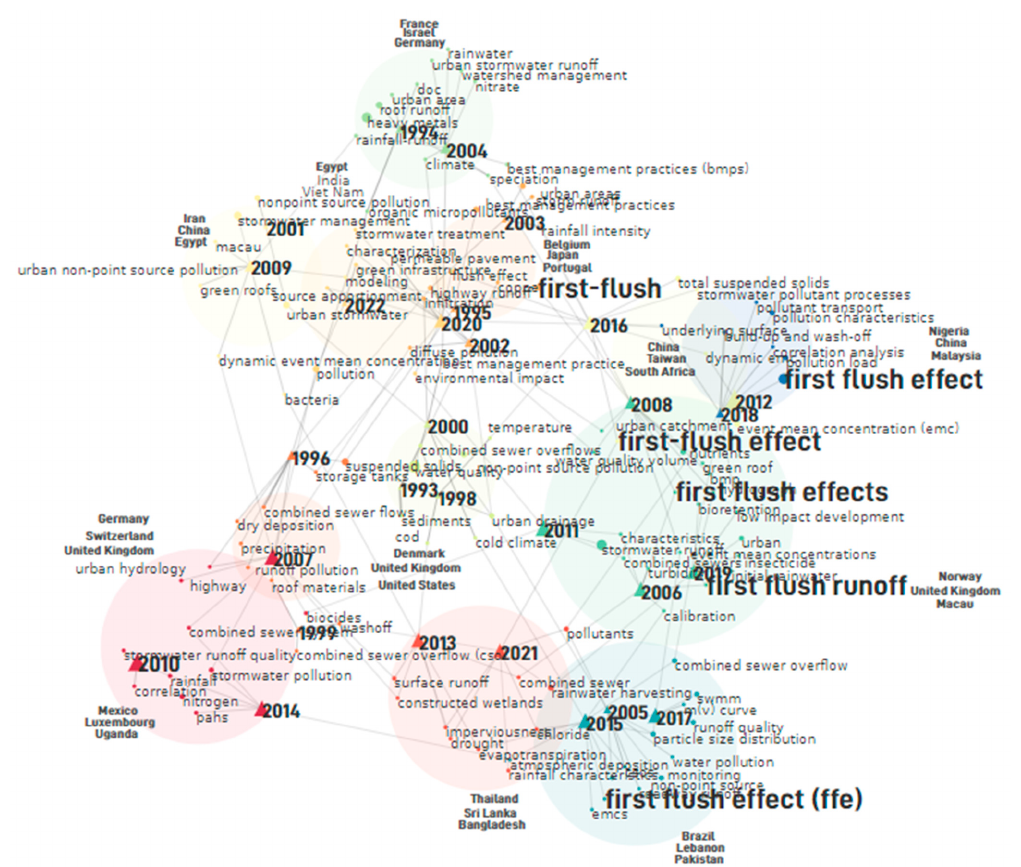
Figure 3. Heterogeneous network map of keywords, countries, and years of the research articles collected from the Scopus database using the keywords “first flush” and “stormwater” or “storm water” or “runoff” and “urban”.